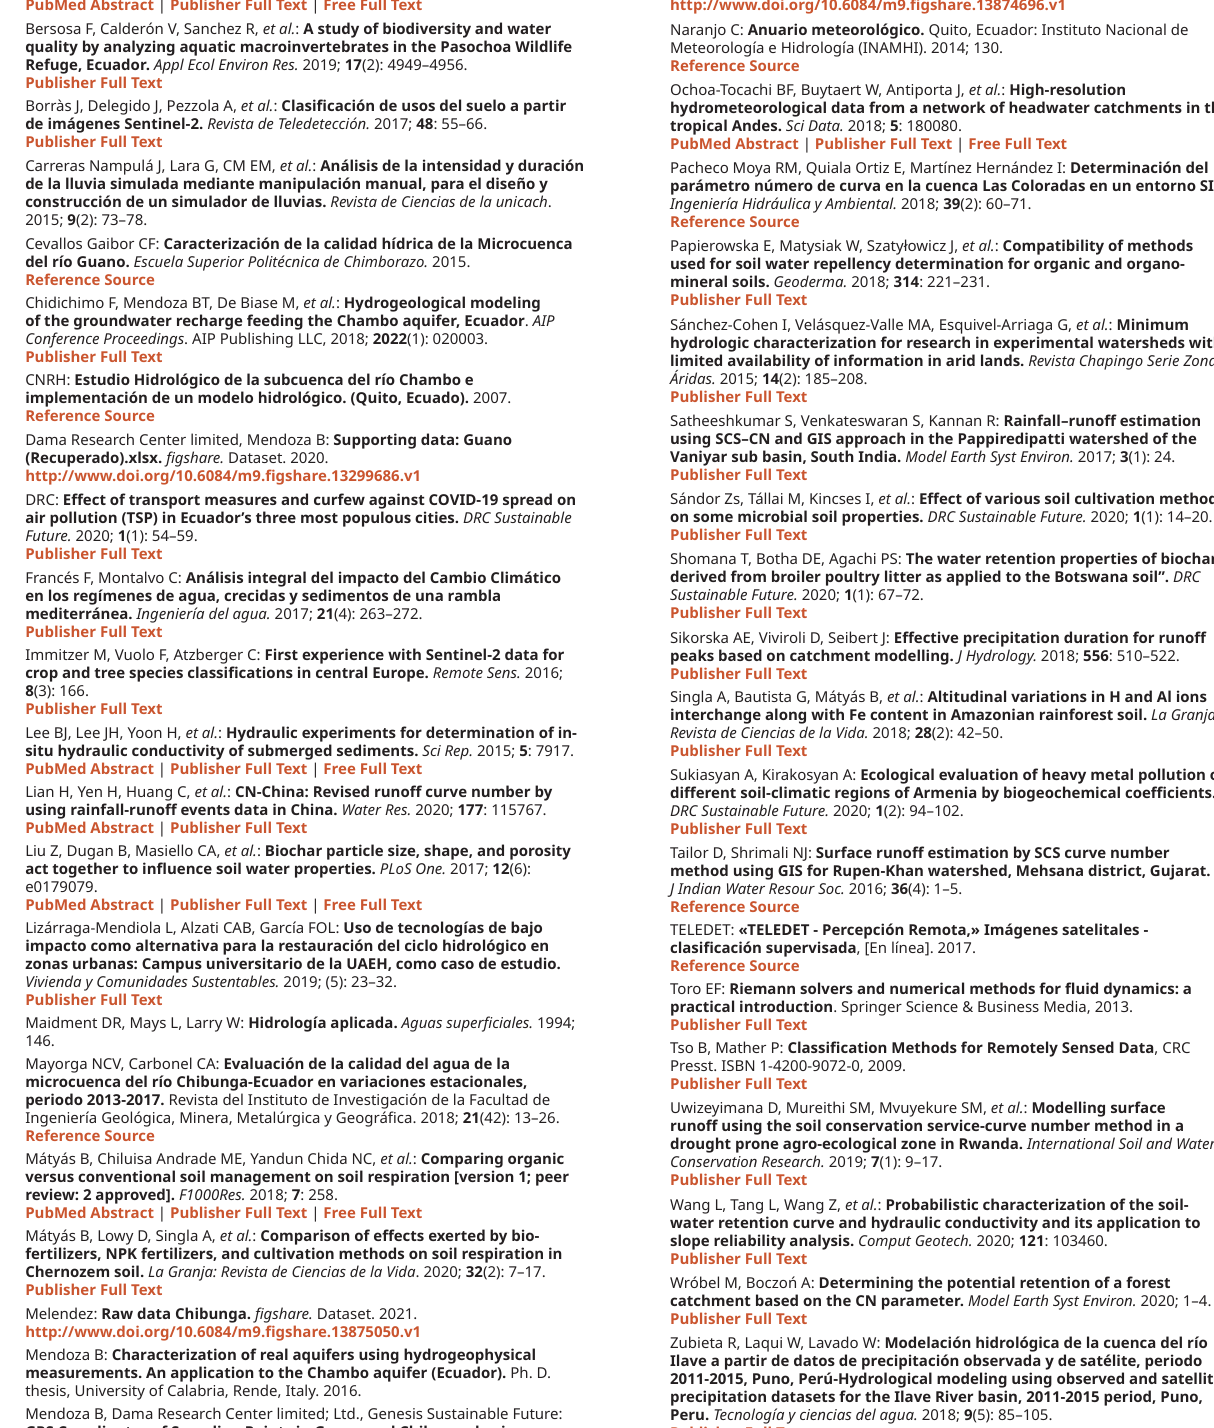
GPS Coordinates of Sampling Points in Guano and Chibunga basins.